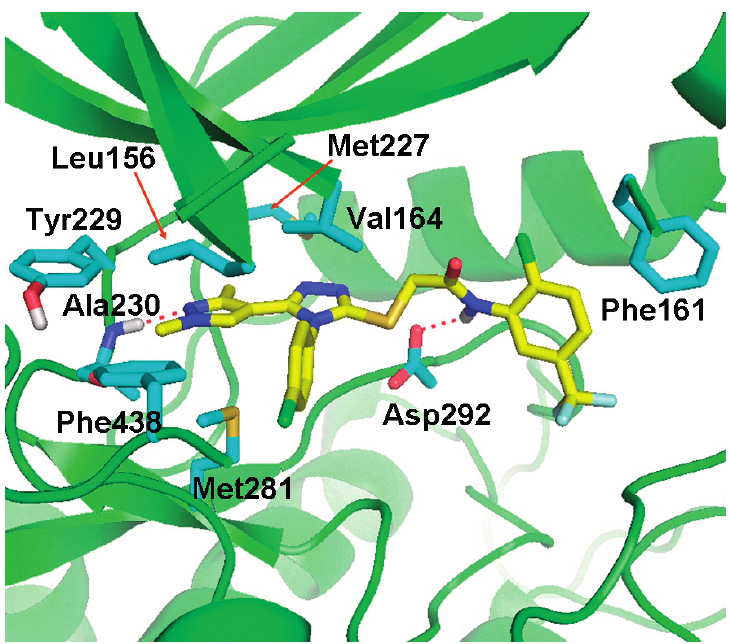
Figure 7. Docking model of Compound a46 fit into the ATP-binding site of Akt kinase. Compound a46 (yellow) and some representative amino acid residues (cyan) interacting with Compound a46 are shown as stick structures. The red dashed lines indicate hydrogen-bonding interactions.